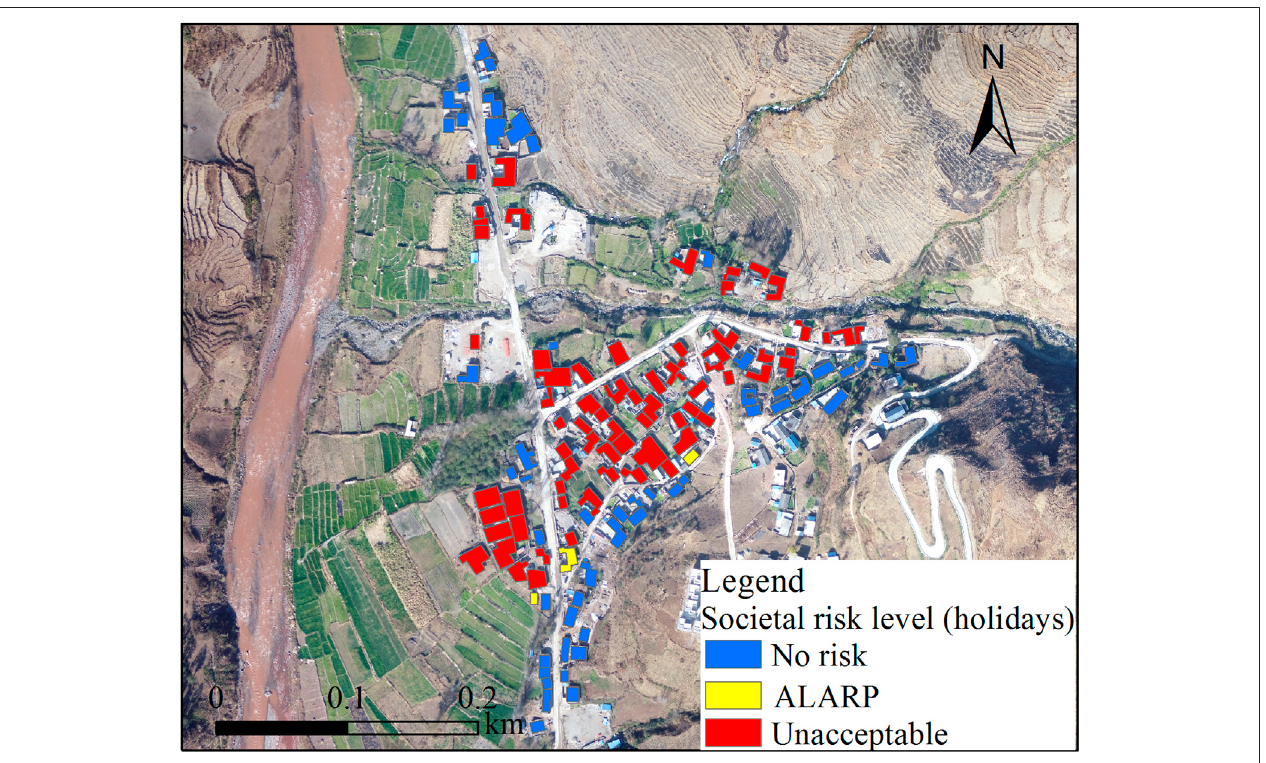
FIGURE 7 | Societal risk map on holidays in Luomo